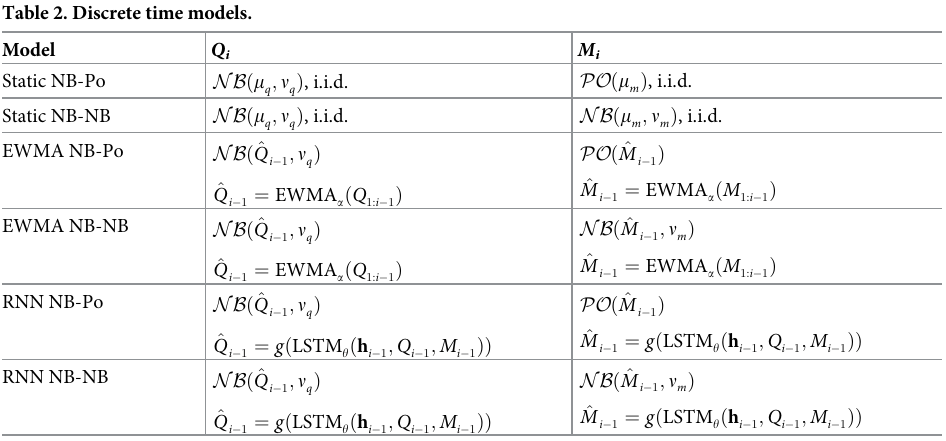
Table 2. Discrete time models.